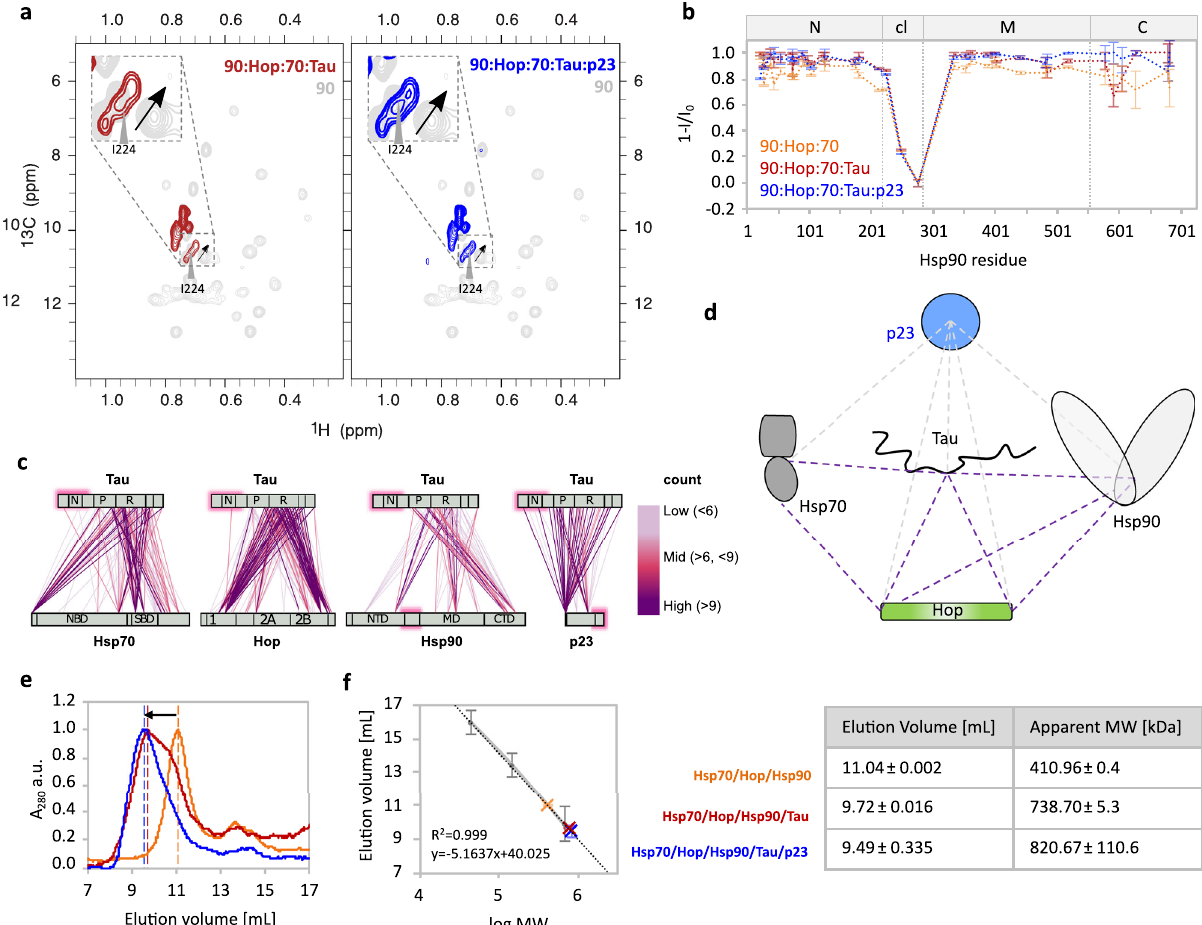
Fig. 4 Molecular interactions within the Tau:Hsp70/Hsp90 multichaperone complex. a 2D 13 C – 1 H methyl-TROSY spectra of Hsp90 alone (light gray) and in the Hsp70:Hop:Hsp90:Tau (red) and the Hsp70:Hop:Hsp90:Tau:p23 complex (blue) with signal splitting of Ile224 (marked with a black arrow). b Peak intensity pro fi le of Hsp90 ’ s isoleucine δ -methyl groups observed in a and (Fig. 3). Hsp90 domains are depicted on top. Error bars were calculated from the signal-to-noise ratio of each spectrum ( n = 1 independent experiment). c DSS crosslink analysis of Tau within the Hsp70:Hop:Hsp90:Tau:p23 complex color coded based on the number of crosslinked peptide spectrum matches (CSMs). Count of CSM higher than 9 (purple), 6 – 9 (pink) and 3 – 6 (rose). Protein domains are indicated as gray bars; Hsp70: NBD-linker-SBD; Hop: TPR1-DP1-TPR2A-TPR2B-DP2; Hsp90: NTD-cl-MD-CTD; Tau: N1-N2-P1- P2-R1-R2-R3-R4-R ’ ; p23: NTD-tail. The pink boxes mark regions likely to remain fl exible. d Major intermolecular crosslinks from c connecting the Tau ’ s repeat domain with Hsp70 ’ s SBD, Hsp90 ’ s CTD, Hop ’ s TPR1 and TPR2B-DP2 and p23. e Size-exclusion chromatograms of the Hsp70:Hop:Hsp90 (orange), the Hsp70:Hop:Hsp90:Tau (red) and the Hsp70:Hop:Hsp90:Tau:p23 complex (blue). The black arrow marks the peak shift upon Tau binding. f Elution